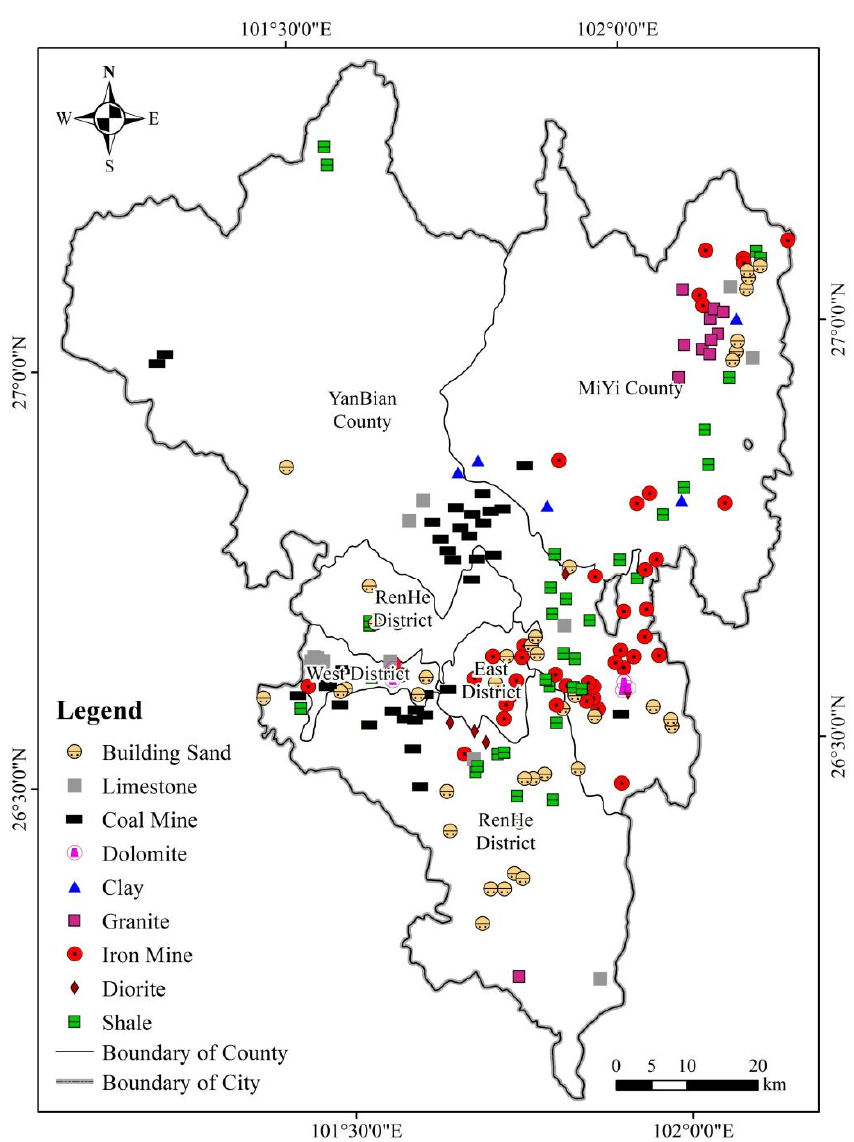
Figure 7. Distribution of various mineral species.